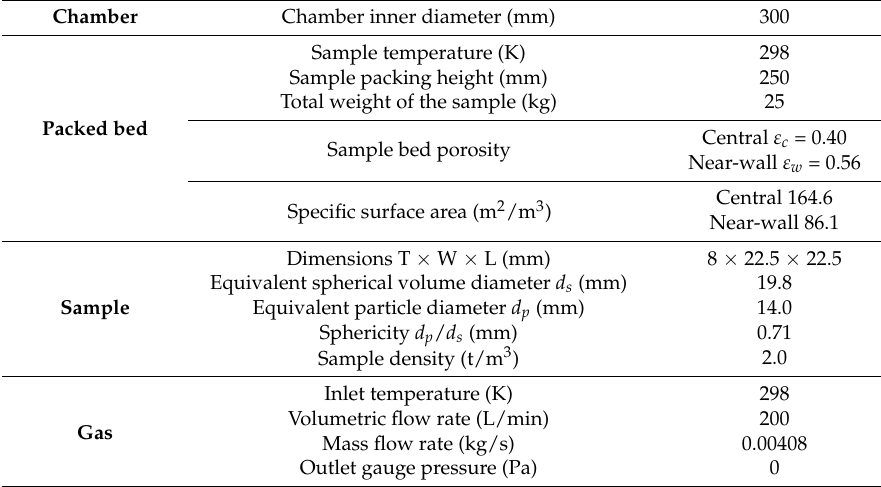
Table 2. Calculation conditions for laboratory-scale CFD simulation.